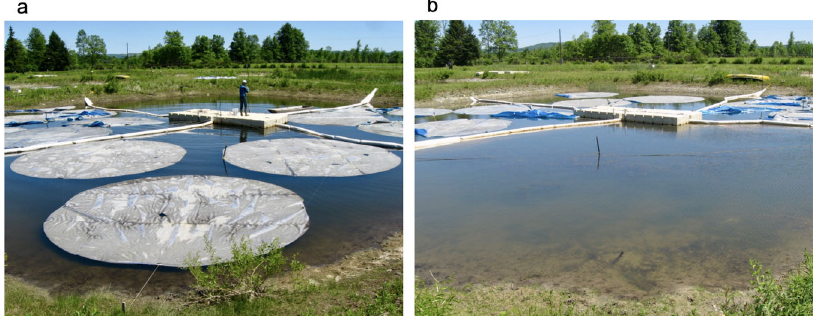
Fig. 1 Ponds used in the experimental test. Pond 217 ( a ) and Pond 218 ( b ) in the Cornell University Experimental Ponds Facility divided into four sections by vinyl-canvas curtains and partially shaded by fl oating mats to regulate primary production rate. Floating docks were placed at the center of the ponds for